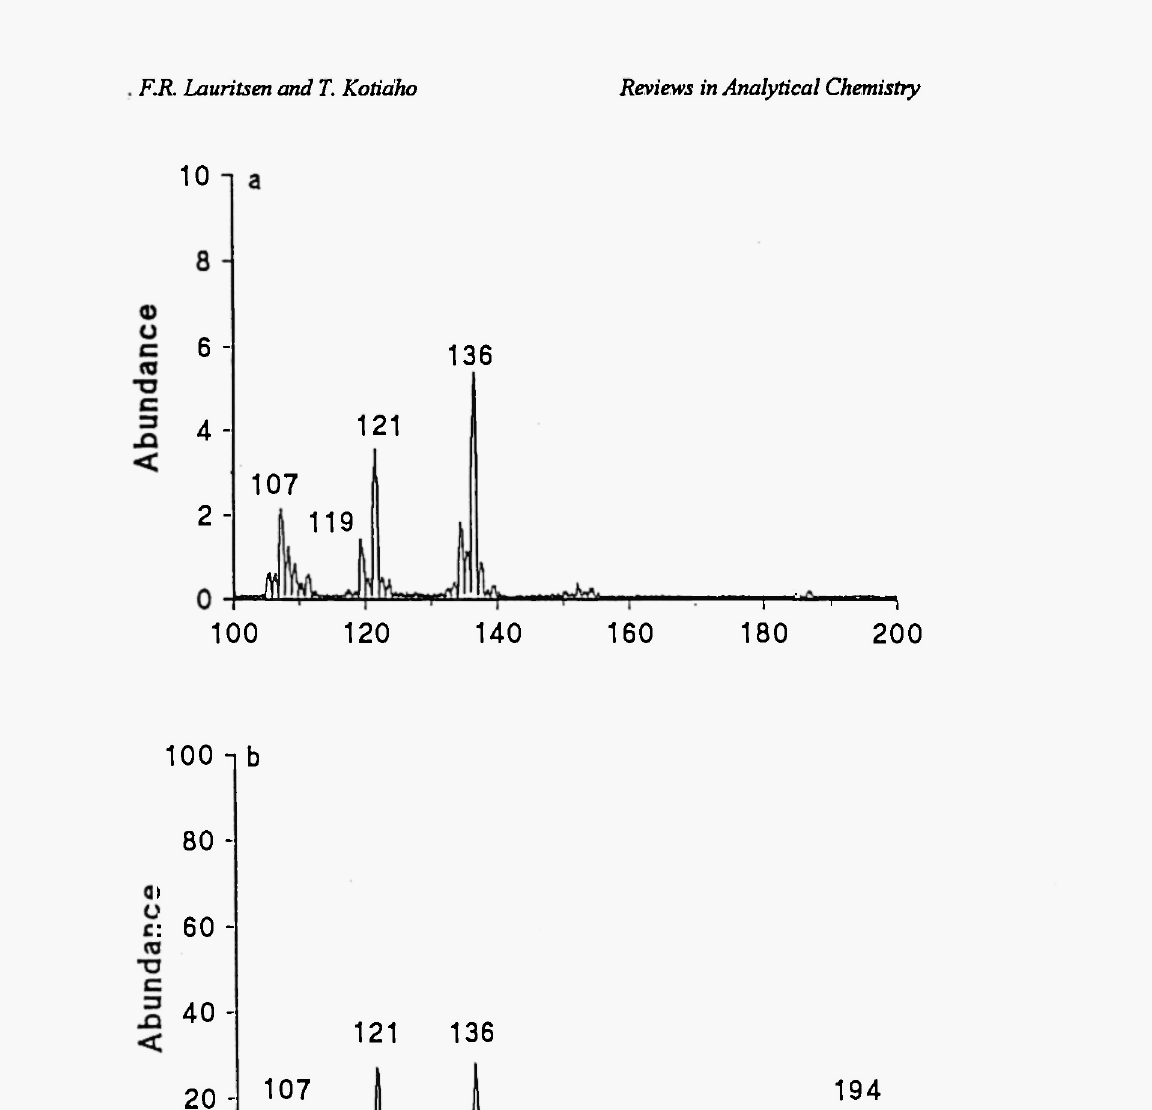
Figure 7. Analysis of flavour compounds in tea. (a) Standard MIMS El-mass spectrum, (b) El-mass spectrum recorded at time of maximal evaporation during a trap and release